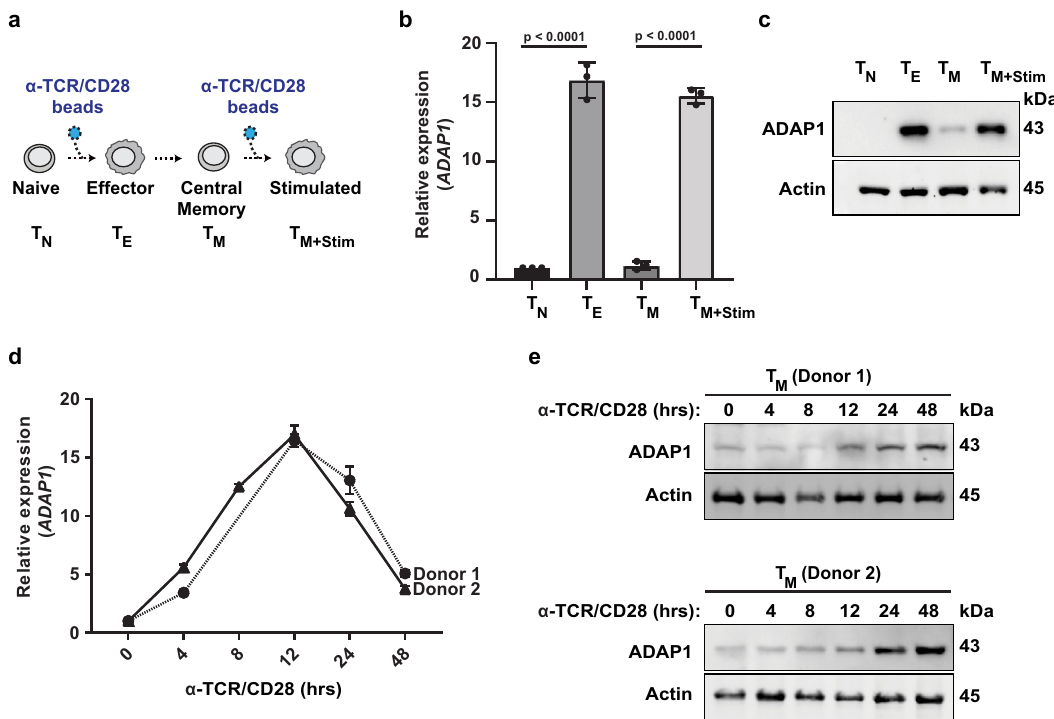
Fig. 2 ADAP1 is expressed in primary human CD4 + T cells. a Schematic of primary CD4 + T cell states generated and analyzed in the subsequent panels. b Relative mean ± s.d. ( n = 3) mRNA expression of ADAP1 in one representative donor across differing T cell states (repeated in two other donors with similar results). T N were sampled on the day of isolation, T M were sampled 18 – 21 days post donor isolation depending on when they reached quiescence, T E and T M + Stim were samples stimulated for 24 h. (one-way ANOVA followed by Dunnett ’ s test for multiple comparisons to mock). c Representative western blot analysis of ADAP1 expression in primary CD4 + T cells across differing states. T N were sampled on the day of isolation, T M were sampled 18 – 21